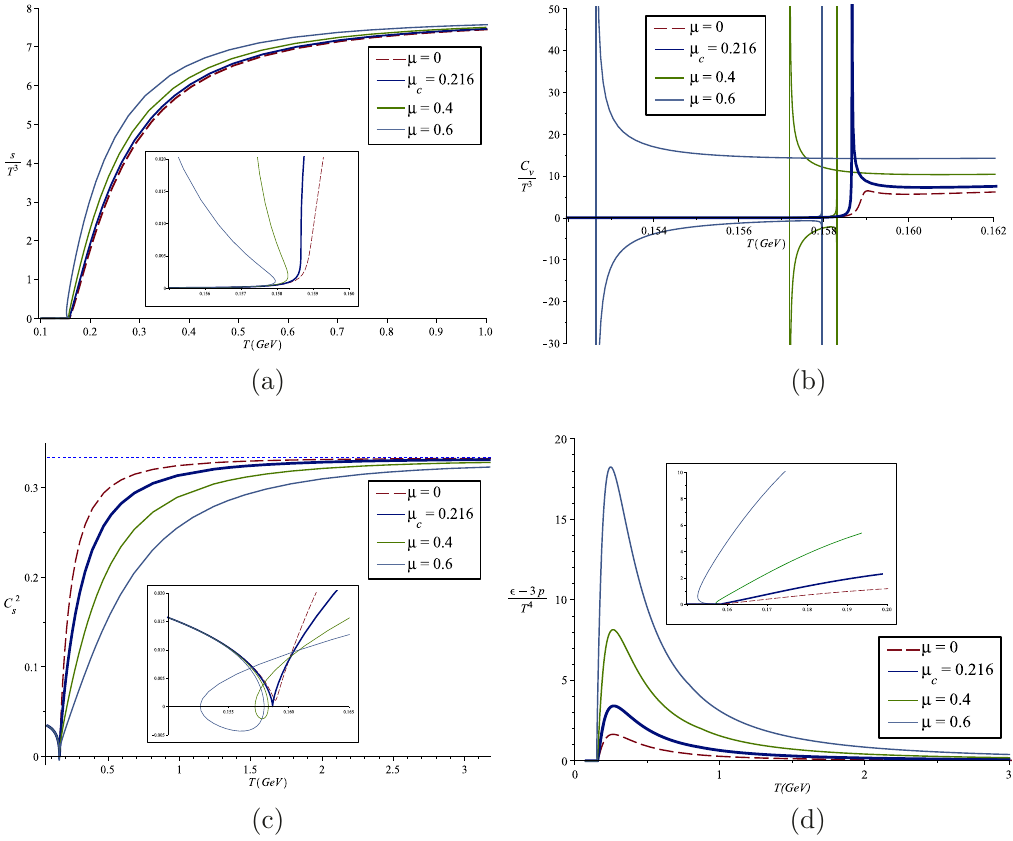
Figure 4 . The entropy, specific heat, speed of sound and trace anomally vs. temperature at different chemical potentials are showed in (a, b, c, d). The phase transition region is